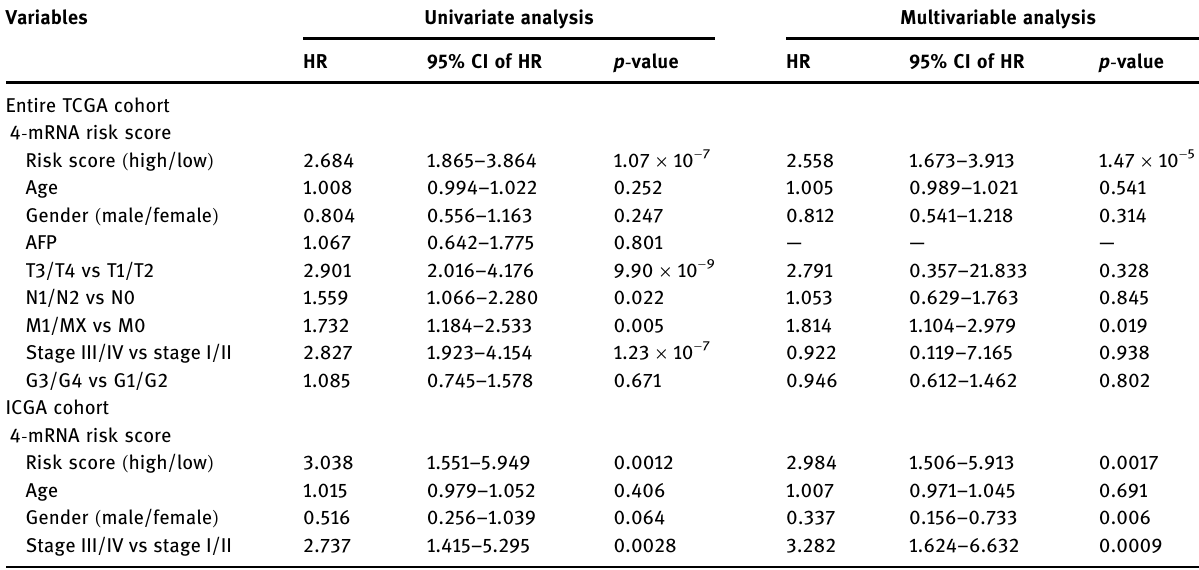
Table 3: Univariate and multivariate COX regression analyses identify clinical factors associated with prognosis Variables Univariate analysis